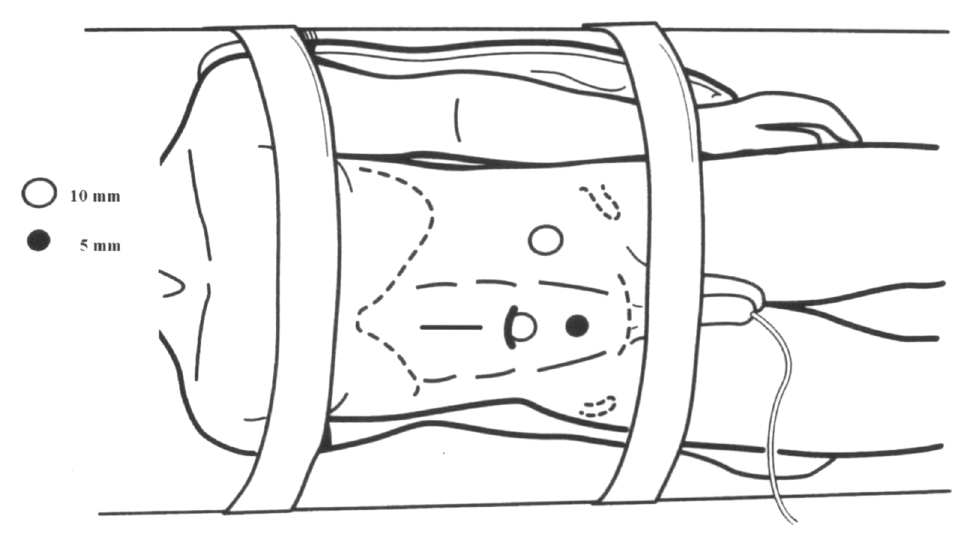
Figure 2 – Positioning, trocars and incision in hand-assisted technique for laparoscopic retroperitoneal